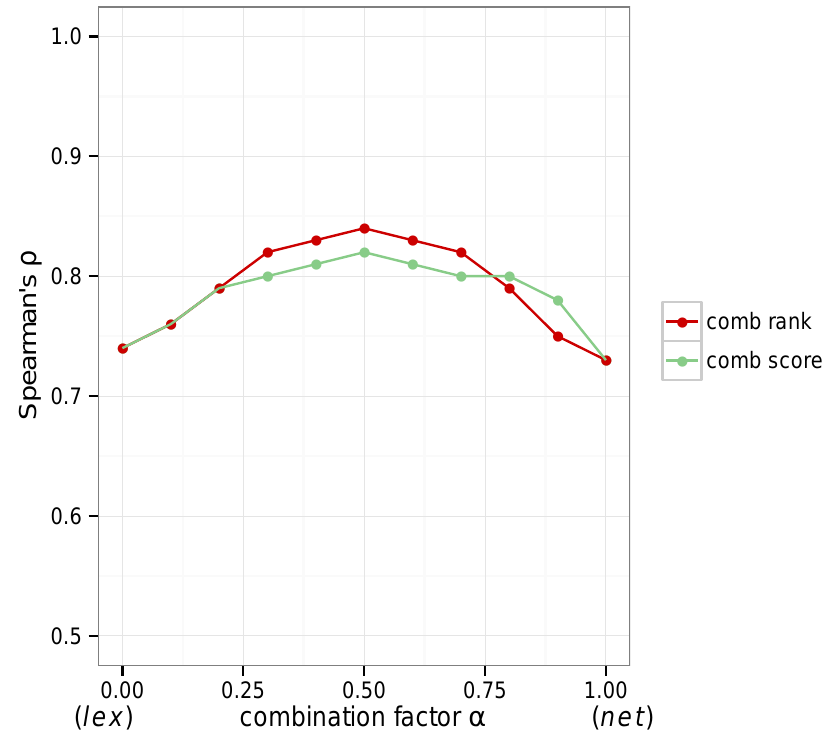
Figure 3. Cognitive plausibility of hybrid measures. comb rank : rank combination s comb score : score combination s